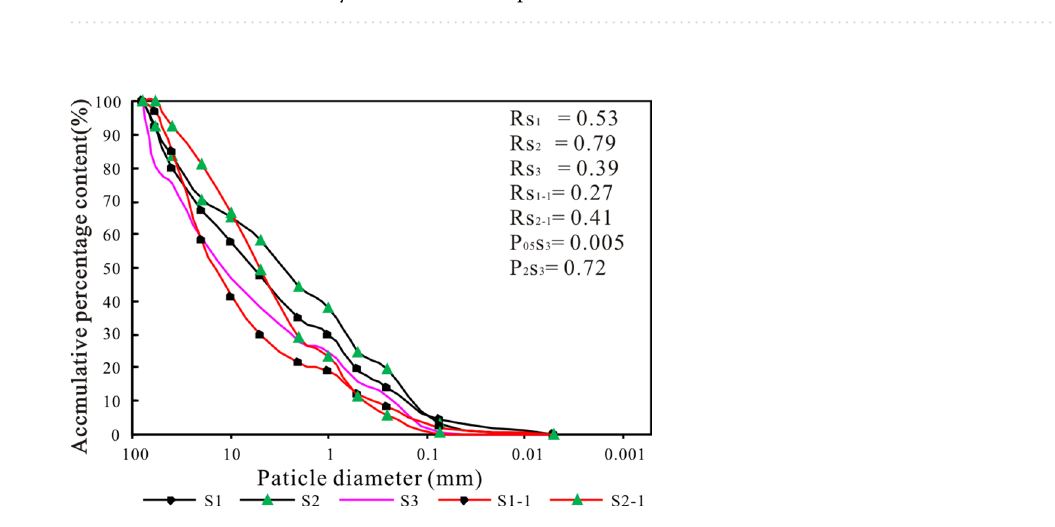
Table 3. Parameters summary of debris flow samples.